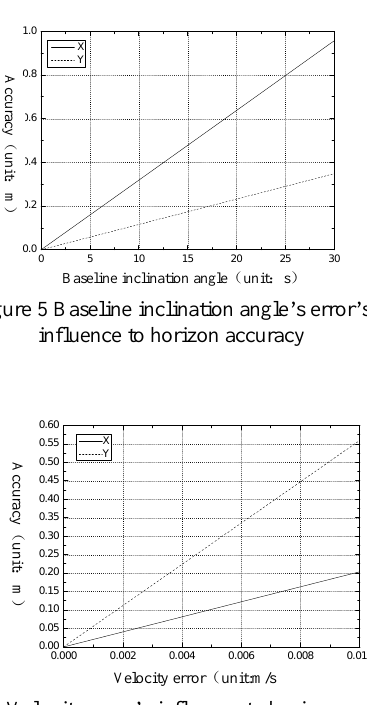
Figure 6 Velocity error’s influence to horizon accuracy